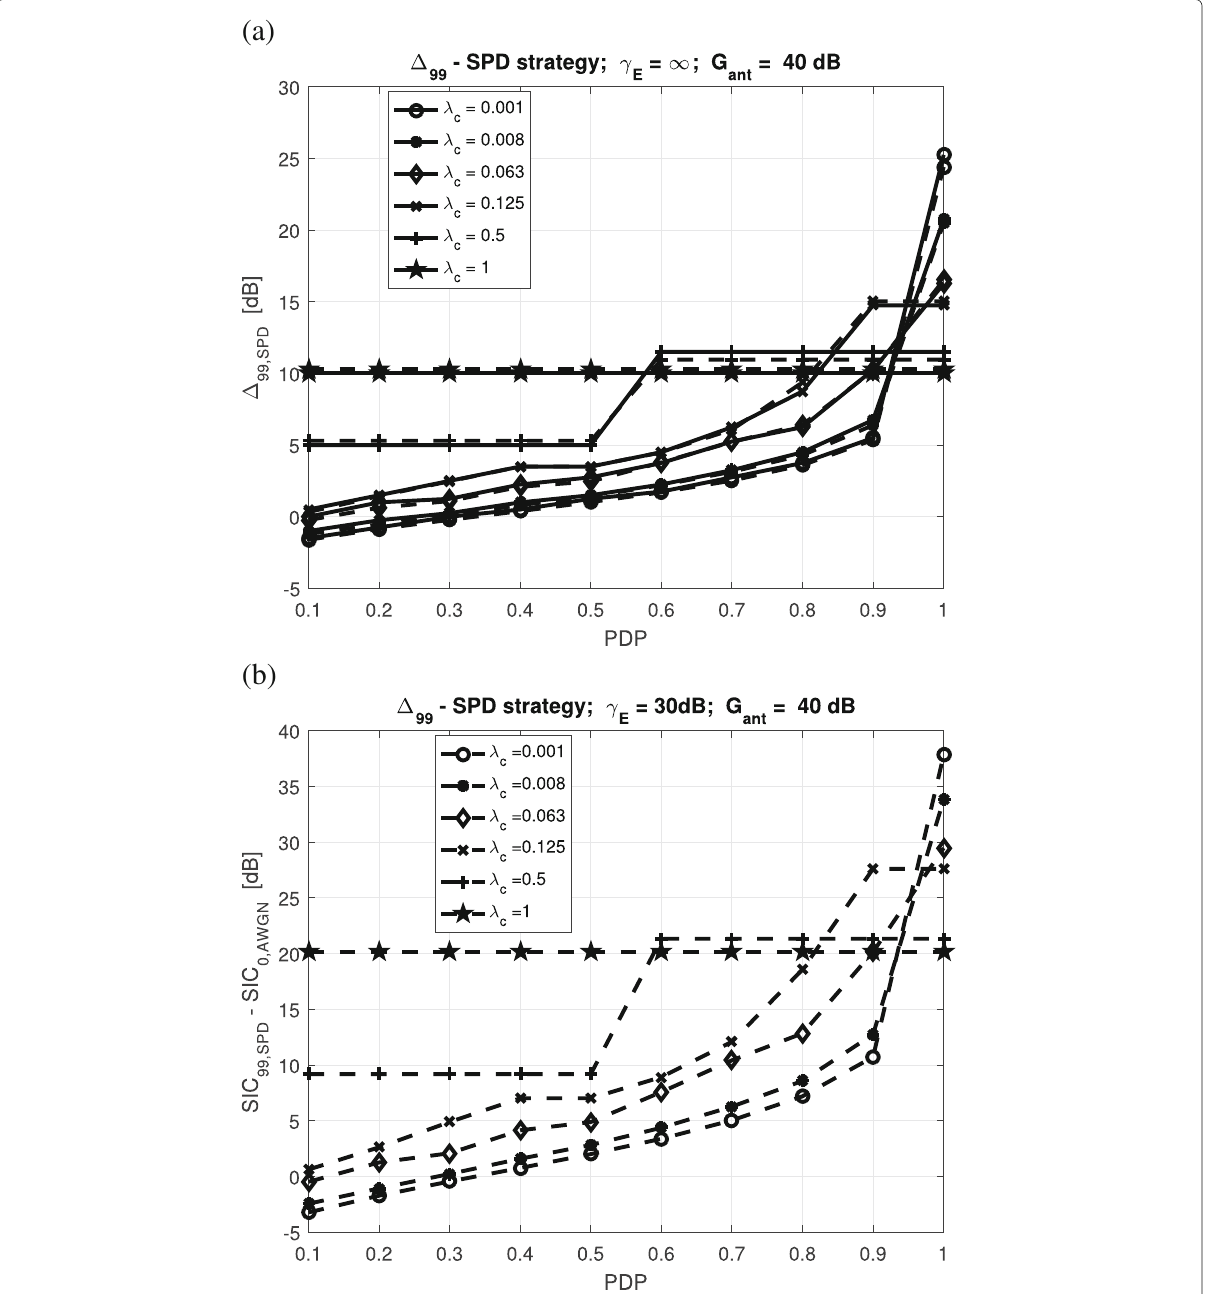
Fig. 6 Margin (cid:9) 99,SPD for frequency selective Rayleigh channel model. a Margin (cid:9) 99,SPD [dB] vs. the parameter PDP with γ E = ∞ and G ant = 40 dB, for different frequency selectivity values λ C . Continuous lines are derived analytically and dashed lines from simulations. b Margin (cid:9) 99,SPD taking into account non-idealities and leakage into the model ( γ E = 30 dB). The results are derived by simulating the Rayleigh fading realizations